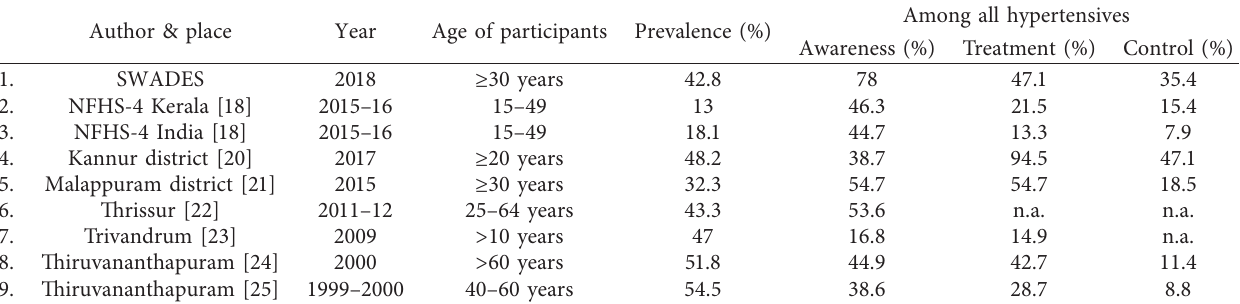
Figure 1: Overall prevalence and awareness of hypertension. Table 3: Summary of prevalence of hypertension from other studies from